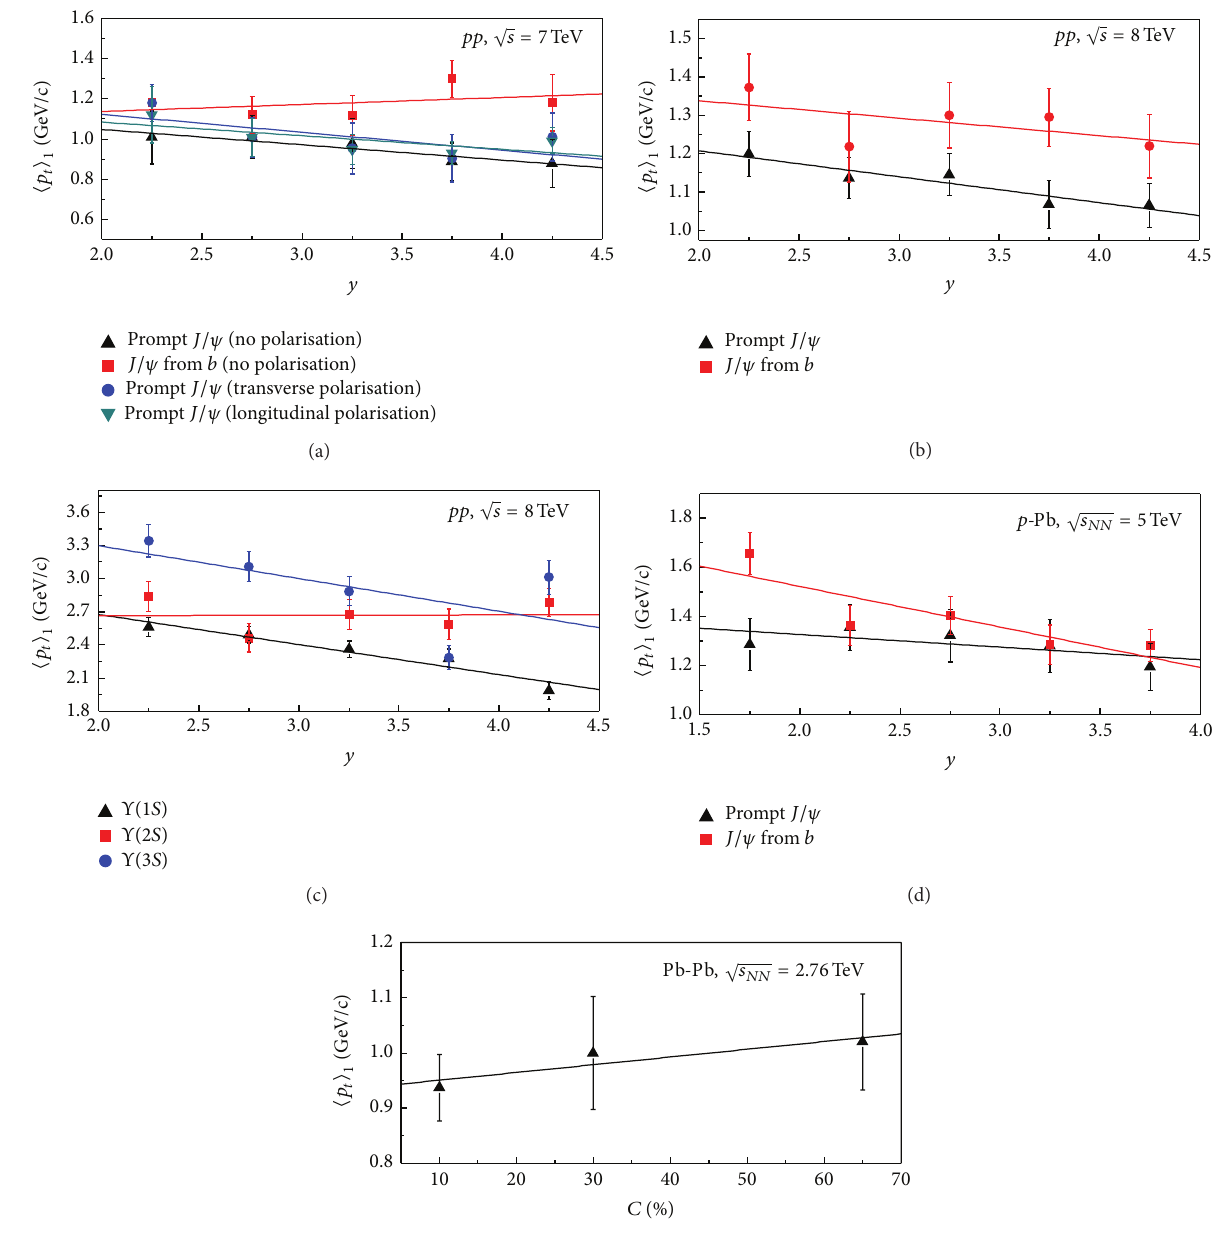
Figure 7: The same as Figure 6 but showing the results for ⟨𝑝 𝑡 ⟩ 1 .